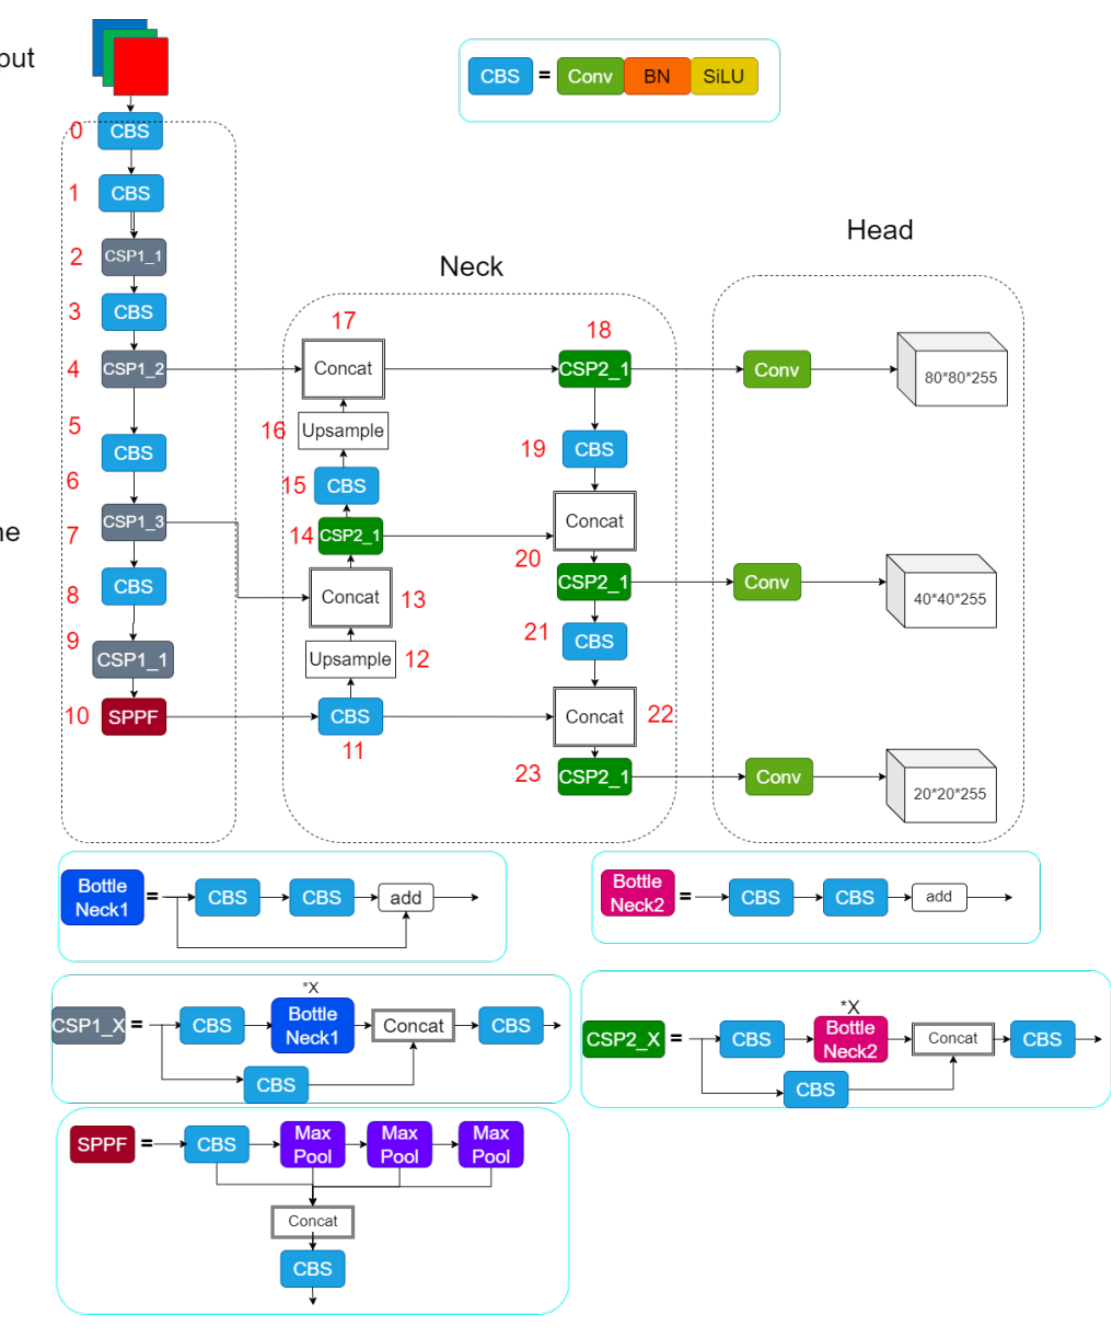
Figure 2. Structure picture of YOLOv5s-6.1.